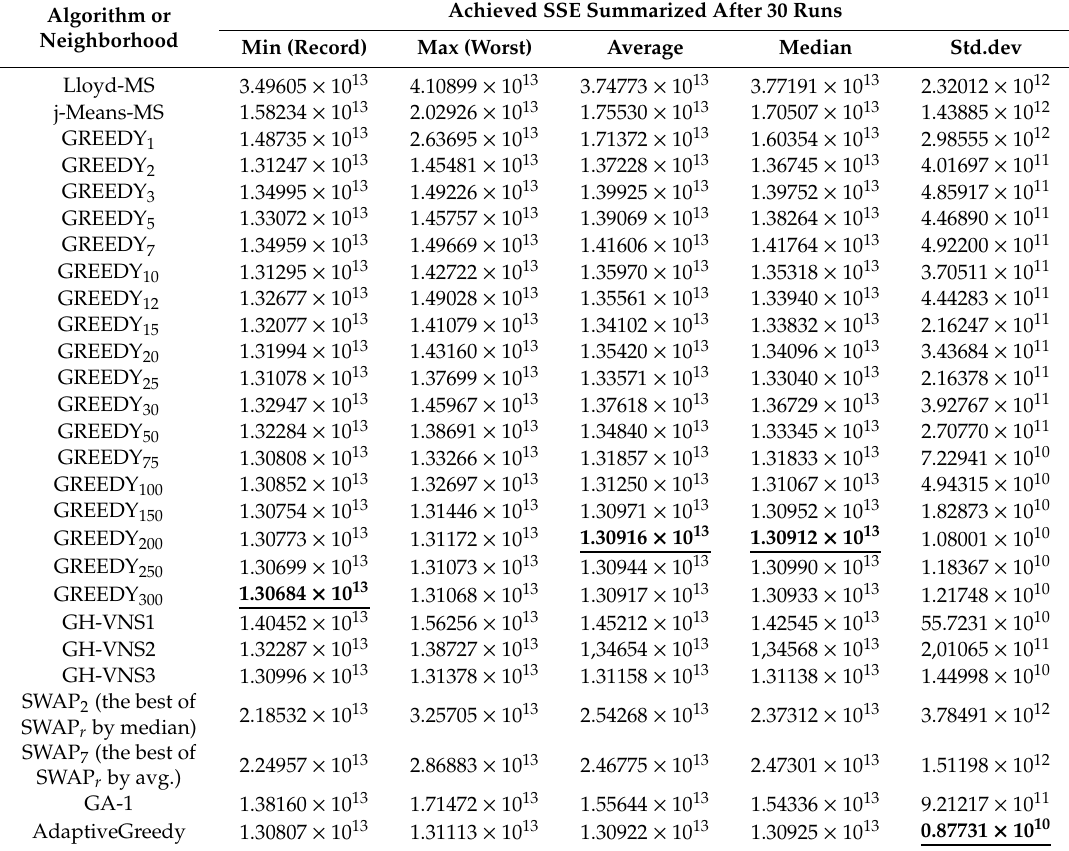
Table A7. Comparative results for BIRCH3 data set. 10 5 data vectors in R 2 , k = 300 clusters, time limitation 10 s.